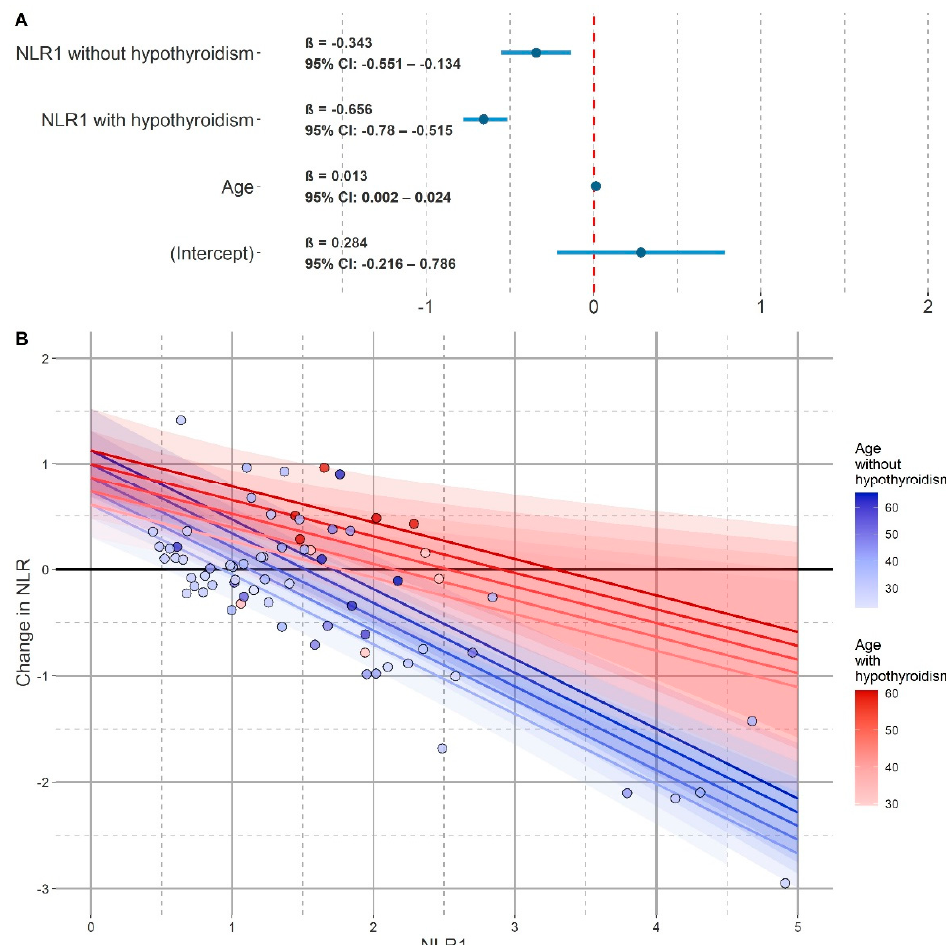
Figure 5. Model for ∆ NLR with interaction (model I ). ( A ) Coefficients plot of model for ∆ NLR with interaction (model I ). NLR 1 —neutrophil to lymphocyte ratio value from the first peripheral blood count. ( B ) Visualization of model I . The horizontal axis represents the value of NLR 1 . The vertical axis represents the change in NLR from peripheral blood counts performed at the beginning of hospitalization to the pre-discharge examination. Patients diagnosed with hypothyroidism were marked on the blue scale, and patients diagnosed with hypothyroidism on the red scale. The darker the shade, the higher the age of the patient. Similarly, different colors of the lines represent predictions for patients without a diagnosis of hypothyroidism (blue scale) and with a diagnosis of hypothyroidism (red scale) and at different ages (the darker the shade, the higher the age). The 95% confidence intervals were marked in a similar manner.